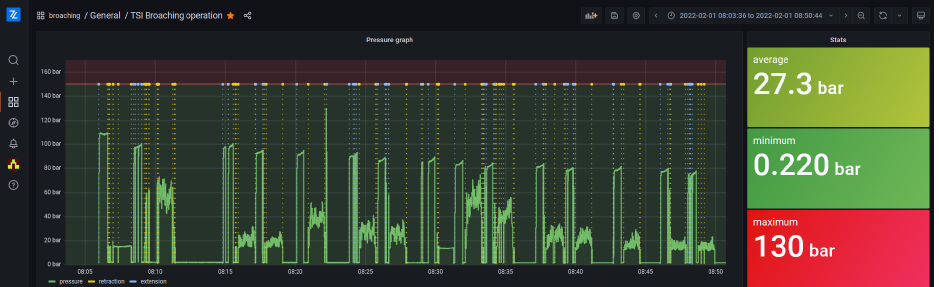
Figure 10. Gradual decline in the pressure during the first few hours of